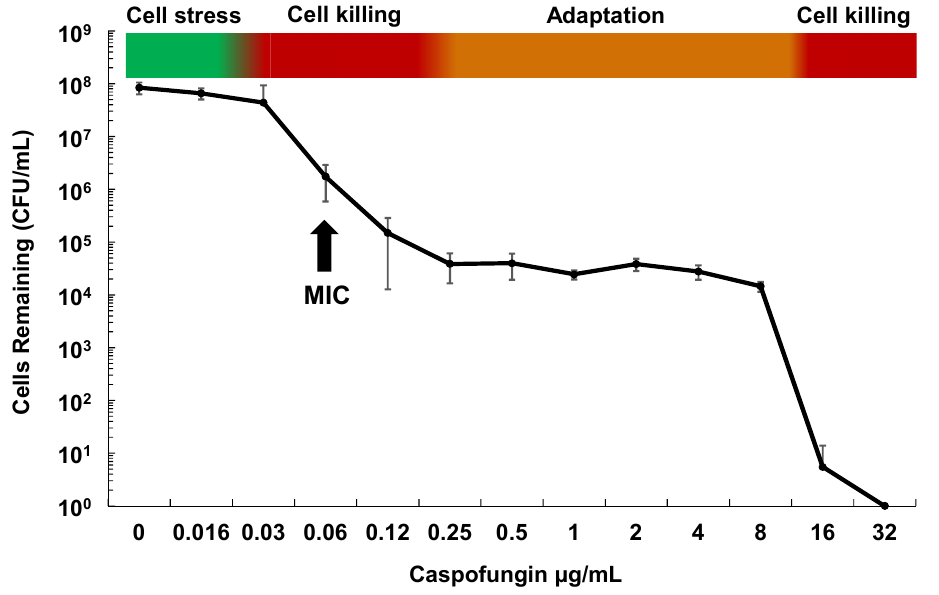
Figure 1. Phases of in vitro cell killing and adaptation with echinocandins and Candida glabrata . Cells (1 × 10 7 ) of C. glabrata ATCC 2001 were grown in RPMI medium containing caspofungin at the indicated concentrations for 20 h. Dilutions were then plated onto drug free agar-containing plates to determine surviving cell counts. Shown is the average of 4 independent experiments ± standard deviations. The minimum inhibitory concentration (MIC) is indicated for reference.